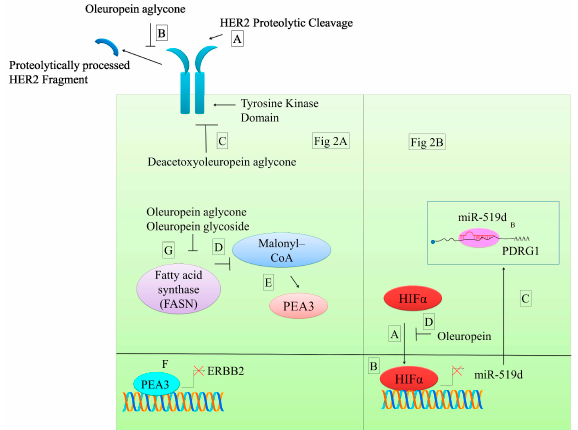
Figure 2. Various anticancer molecular mechanisms of oleuropein. ( A ) HER2 is proteolytically processed that is inhibited by oleuropein. Deacetoxyoleuropein aglycone inhibits activation of HER2. Malonyl-coenzyme A (CoA) plays a role in transcriptional repression of ERBB2 by facilitating entry of PEA3 in the nucleus. PEA3 binding sites are present within the promoter region of ERBB2. ERBB2 overexpressing breast cancer cells had lower levels of PEA3. As a result of oleuropein aglycone and oleuropein glycoside-mediated inhibition of FASN, higher levels of malonyl–CoA continue to be generated. Cytosolic accumulation of higher levels of malonyl-CoA triggered an increase and entry of PEA3 in the nucleus, where it occupied the PEA3 binding site and transcriptionally repressed ERBB2; ( B ) Hypoxia-inducible factor (HIF α ) enters into the nucleus and transcriptionally represses miR-519d. miR-519d is involved in negative regulation of PDRG1 in cancer cells. However, treatment of cancer cells with oleuropein inhibits HIF α -mediated transcriptional repression of miR-519d and consequently miR-519d quantitatively inhibits